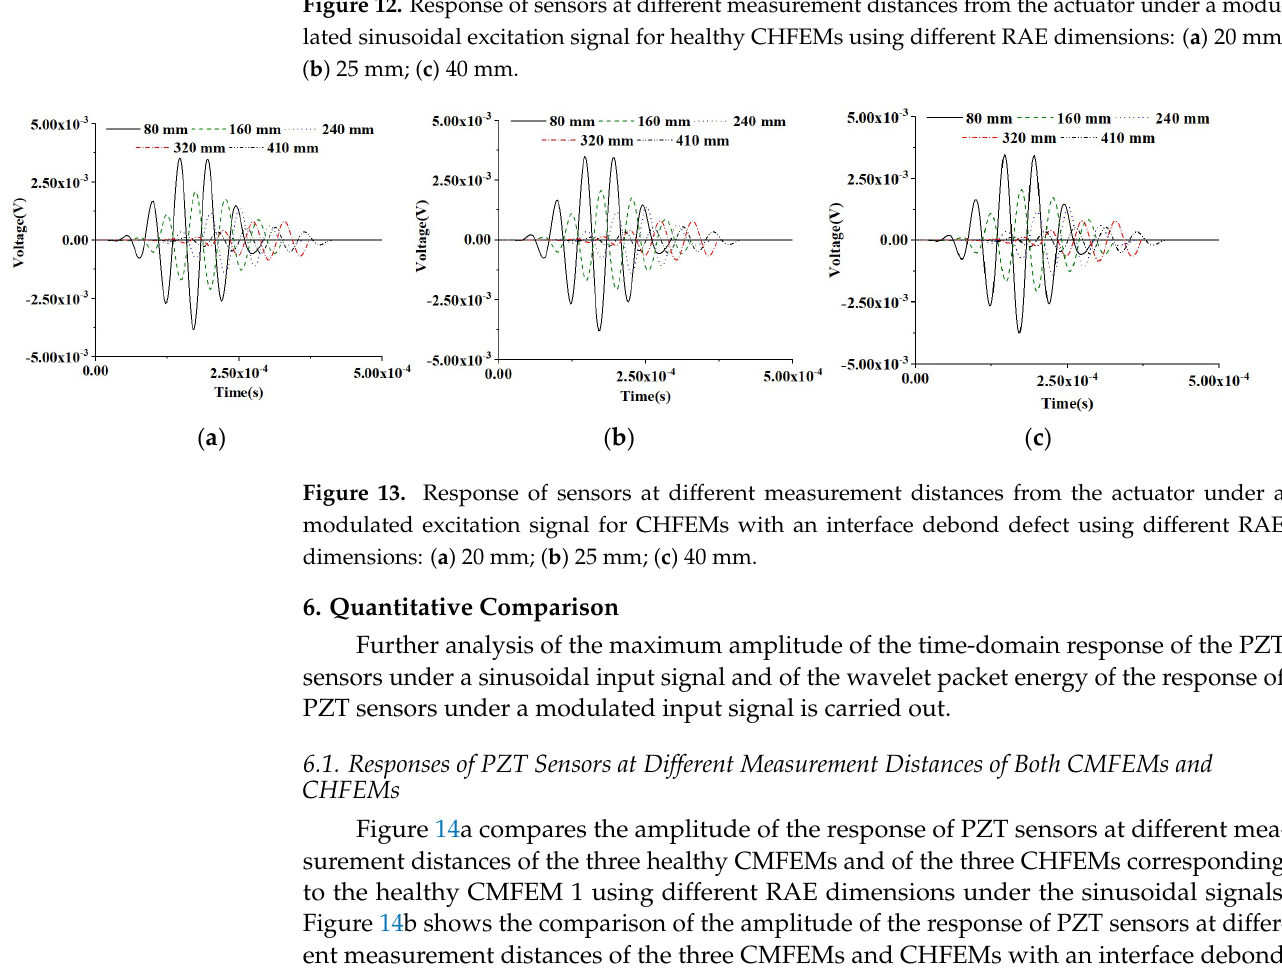
( b ) Figure 14. Comparison of the responses of PZT sensors between CMFEMs and CHFEMs corre- sponding to CMFEM 1 with different RAE sizes under sinusoidal signals. ( a ) Healthy CMFEMs and CHFEMs, and ( b ) CMFEMs and CHFEMs with an interface debond defect. Figure 14a compares the amplitude of the response of PZT sensors at different meas- urement distances of the three healthy CMFEMs and of the three CHFEMs corresponding to the healthy CMFEM 1 using different RAE dimensions under the sinusoidal signals.